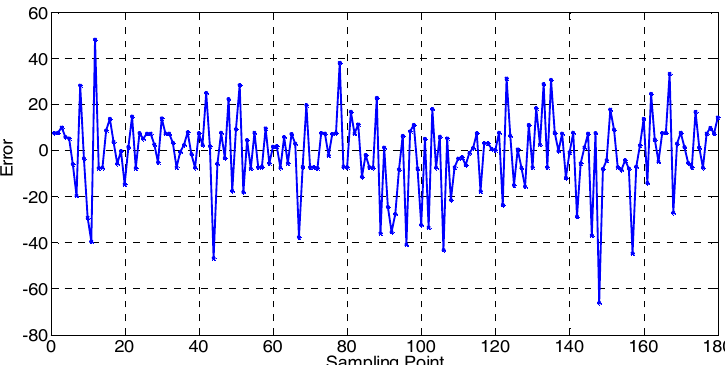
Figure 12. The analysis of the SVM model estimation error.